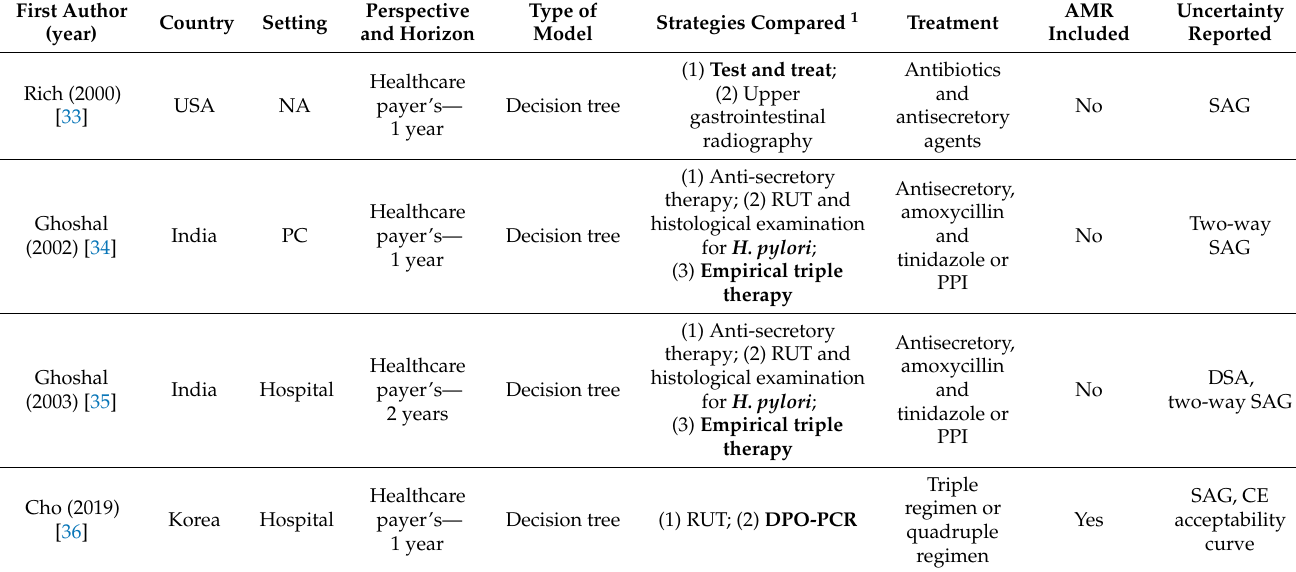
Table 3. Articles related to diagnosing H. pylori infection associated with duodenal ulcers.